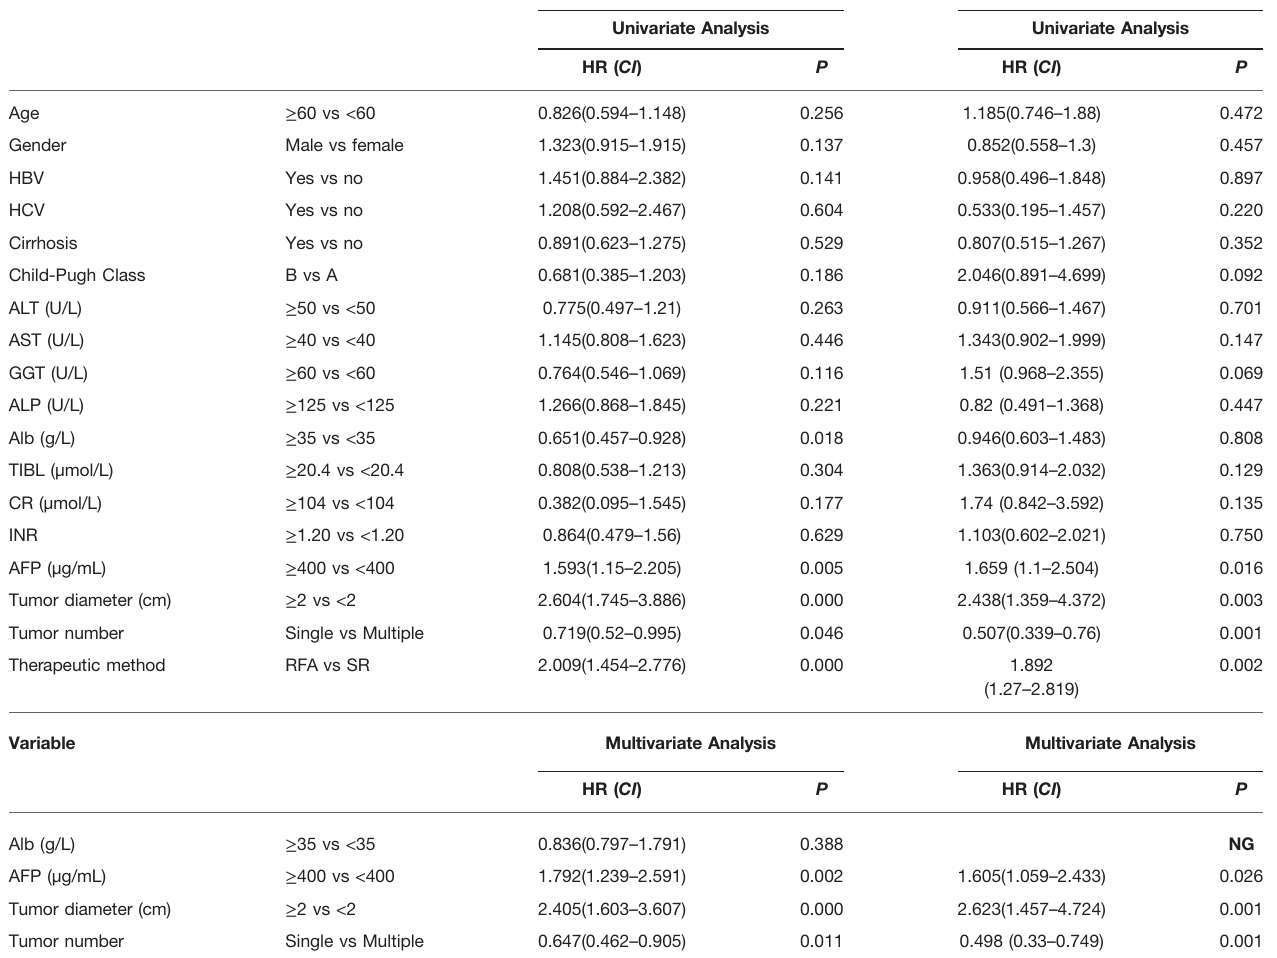
TABLE 3 | Univariate and multivariate analysis to identify independent risk factors of RFS in CTC-positive